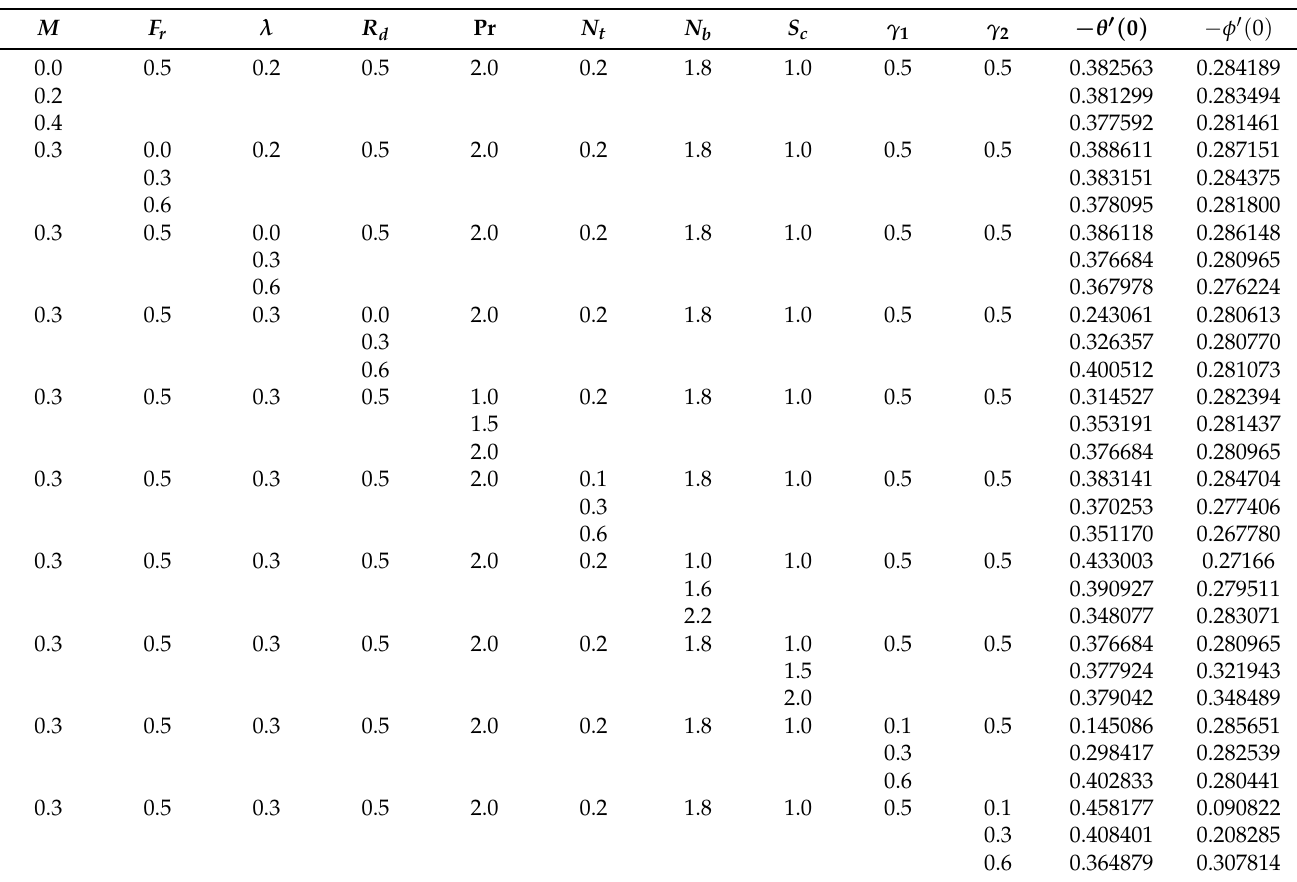
Table 2. Numerical data obtained for Nusselt and Sherwood numbers setting n = 1.5, k 0 =